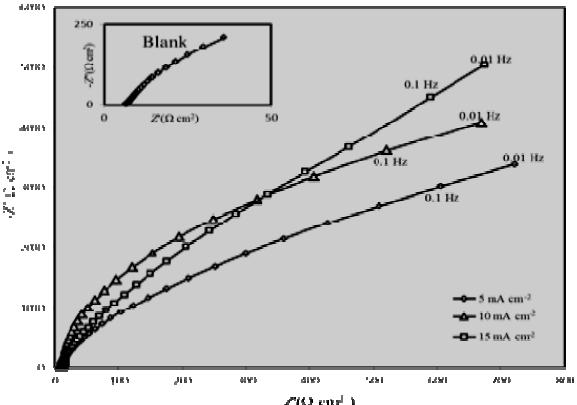
Fig. 9. Nyquist impedance plots for uncoated AA3004 and polyaniline-TiO nanocomposite- coated AA3004 2 synthesized under galvanostatic conditions at various current densities (mAcm -2 ) and the plots recorded at open circuit potential in aqueous solution of 3.5% NaCl.